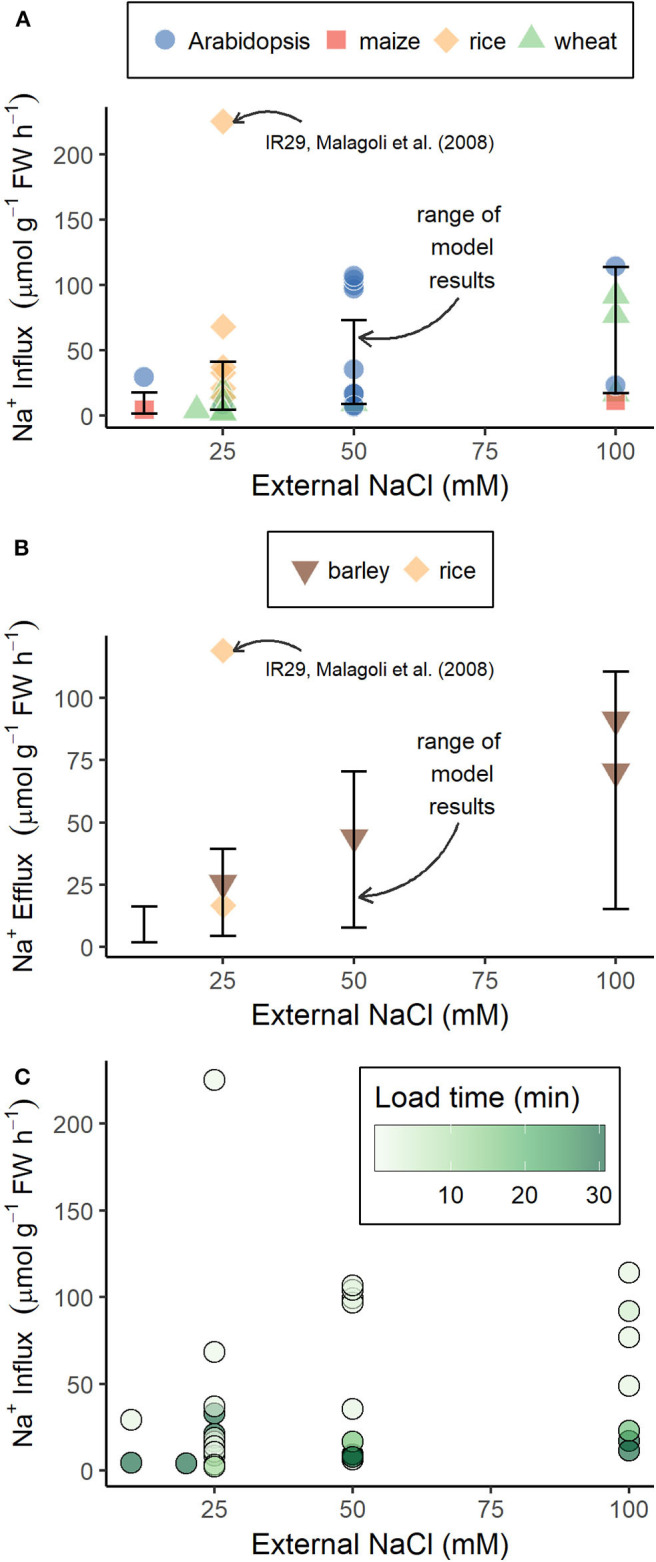
Model steady-state Na+ influxes and effluxes across outer root cell plasma membranes are similar in magnitude to influxes and effluxes measured using radioactive tracers. (A) Na+ influxes measured using 22Na+ or 24Na+ (symbols), or simulated using our model (error bars); (B) Na+ effluxes measured using 24Na+ (symbols) or simulated using our model (error bars); and (C) experimental Na+ influxes shown in (A) with tracer loading time indicated by color. Experimental results were obtained from Malagoli et al. (2008), Essah et al. (2003), Wang et al. (2006), Wang et al. (2009), Maathuis and Sanders (2001), Elphick et al. (2001), Moller et al. (2009), Jha et al. (2010), Davenport and Tester (2000), Laurie et al. (2002), Zidan et al. (1991), Davenport et al. (2005), Davenport et al. (2007), Demidchik et al. (2004), Flam-Shepherd et al. (2018), Kronzucker et al. (2006), and Kronzucker et al. (2008). Error bars indicate the range of model Na+ fluxes across outer root cell plasma membranes obtained for the range of external conditions used in the simulations in Figure 2.